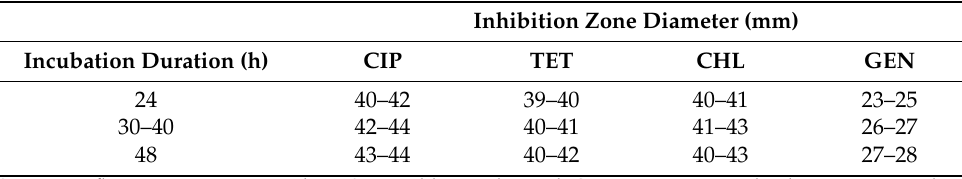
Table 12. Disc-diffusion inhibition zones of F. tularensis at various time points.